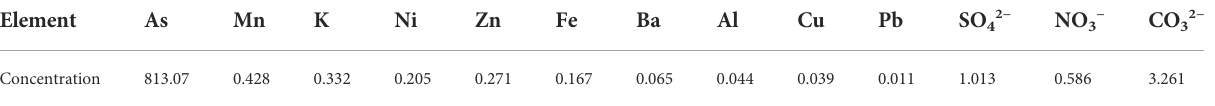
TABLE 1 Composition of the gold-smelting wastewater after the original treatment process of fl occulation and precipitation using mainly lime (mg/L). Element